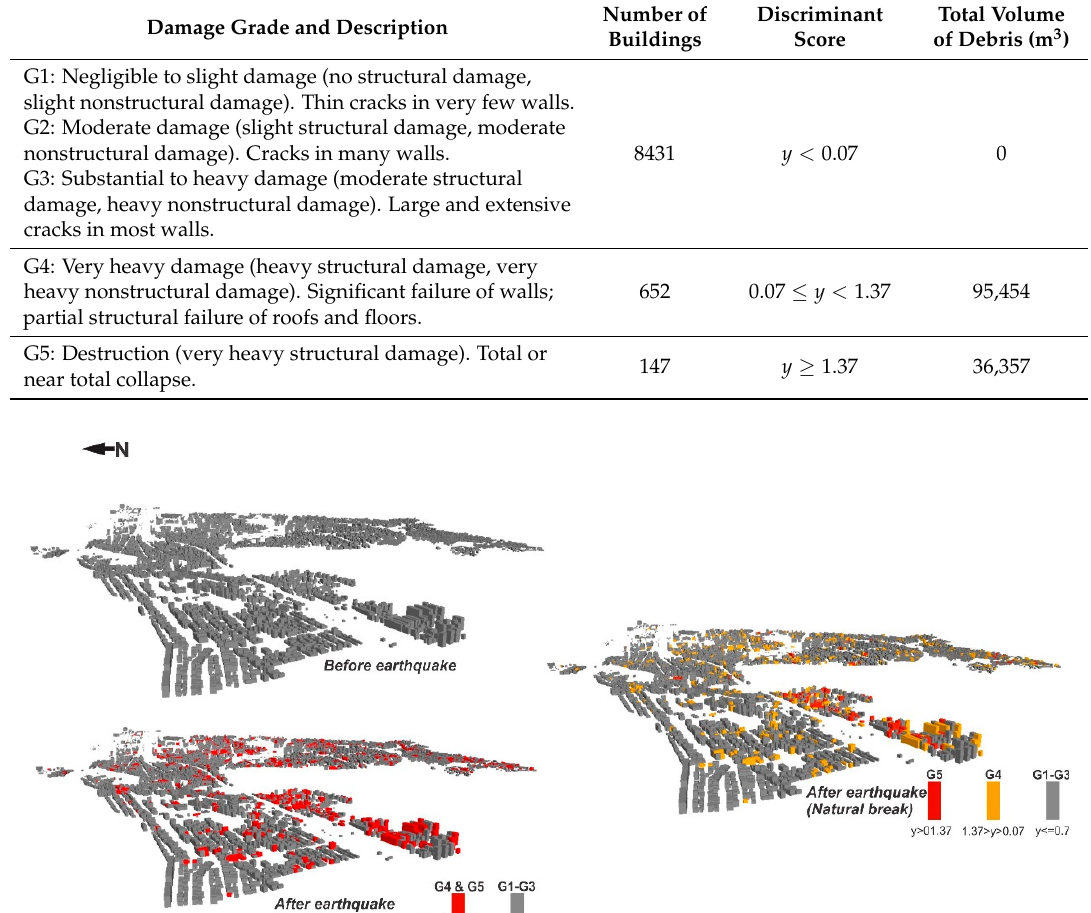
Table 3. EMS-98 damage description of masonry buildings, damage scores and total volume of debris in Sarpole-Zahab. Damage Grade and Description